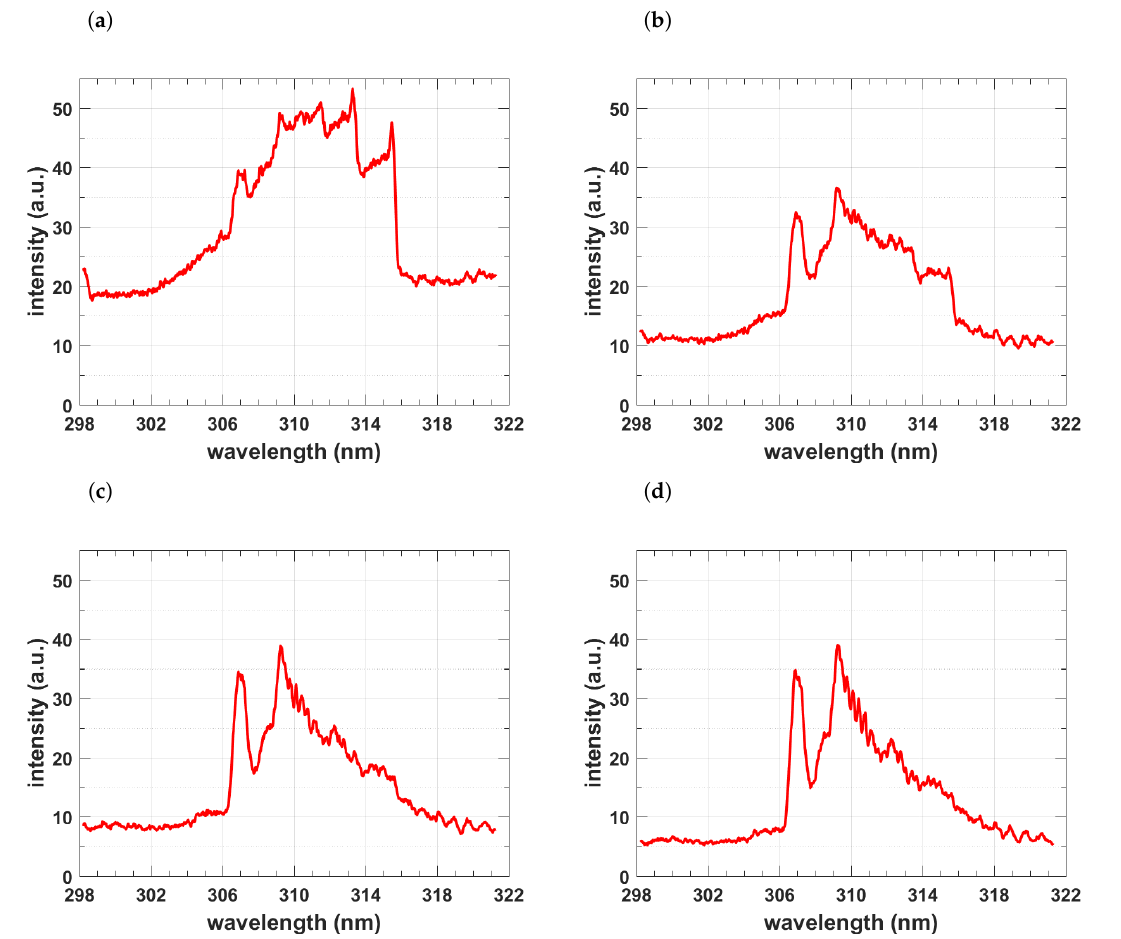
Figure 6. Average of spectra between 4.2 and 8.2mm of Figure 5. Gate width: 10 µ s, time delay ( a ) 20 µ s—primarily N 2 second positive spectra ( b ) 30 µ s, ( c ) 40 µ s, and ( b ) 50 µ s—primarily OH spectra.